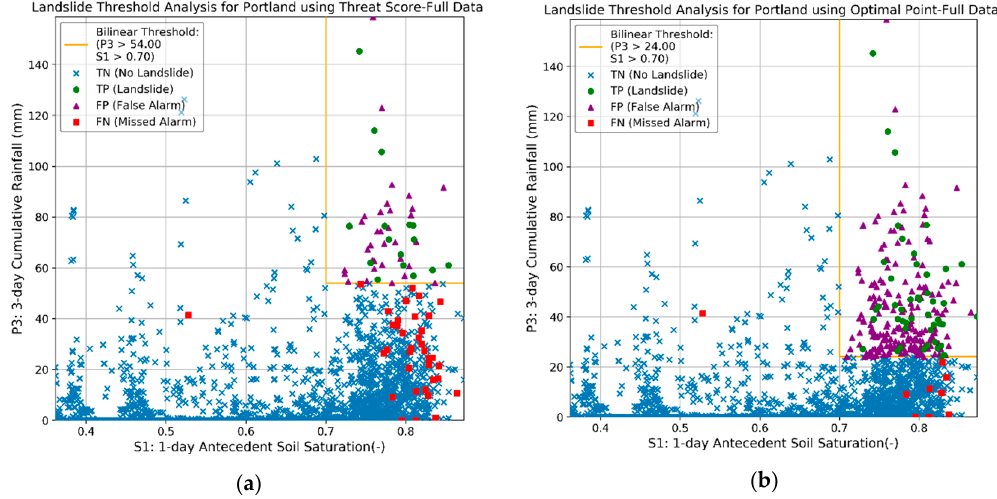
Figure 3. HydroMet output plot showing optimized threshold using a P3:S1 variables for two different skill statistics: threat score and optimal point, showing respectively a more conservative and a more balanced threshold. ( a ) An optimized threshold using the threat score statistic, which resulted in a threshold of precipitation greater than 54 mm and a saturation greater than 0.7. ( b ) The optimized threshold using the optimal point statistic, which resulted in a threshold of precipitation greater than 24 mm and a saturation greater than 0.7.